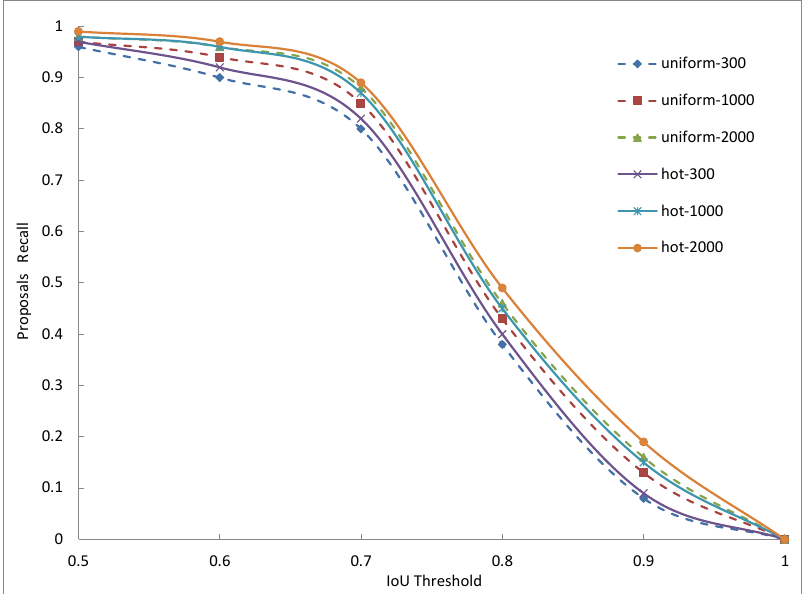
Figure 7. The recall of proposals with different IoU threshold. uniform refers to the uniform anchors and hot refers to the hot anchors. For example, the uniform-300 means the top-300 proposals computed from the uniform